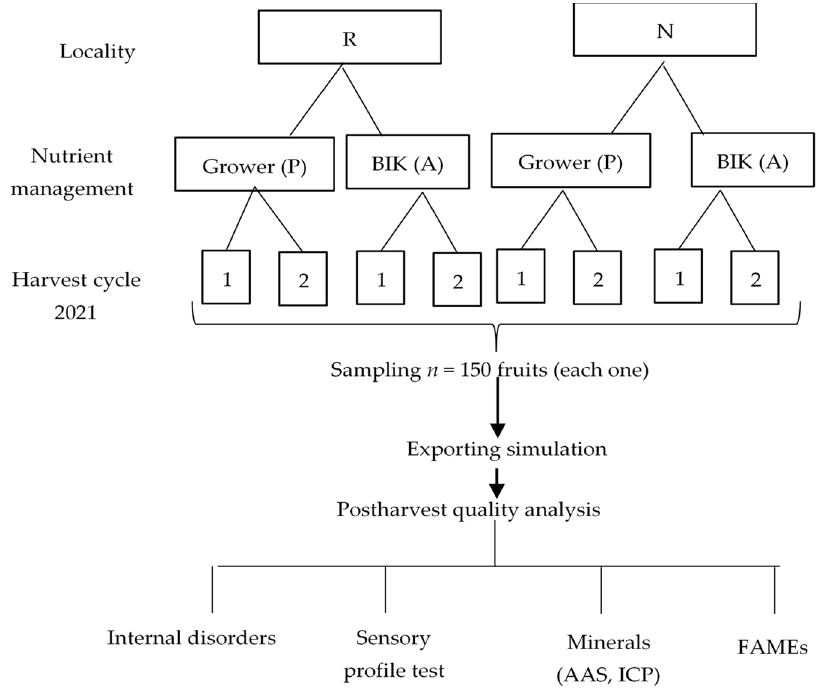
Figure 1. Schematic representation of the experimental design and postharvest quality analysis. Lo- cality (orchard): R, N. BIK: Balanced Indices of Kenworthy. P: nutrient management of the farmer. A: Nutrient management based on the BIK. Harvest cycle: 1. Harvest from the intermediate flowering period. 2. Harvest from the main flowering period. FAMEs: fatty acid methyl esters. AAS: Atomic absorption spectroscopy. ICP: Inductively Coupled Plasma.